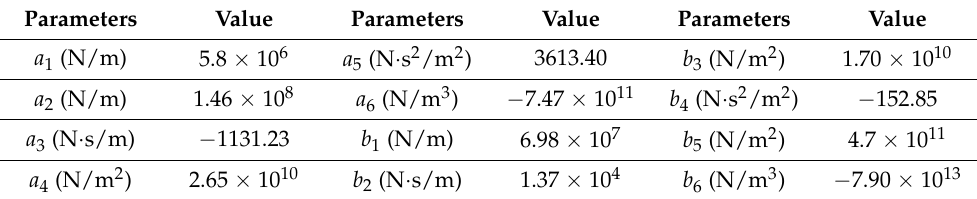
Table 2. Nonlinear parameters of the dynamic rolling force